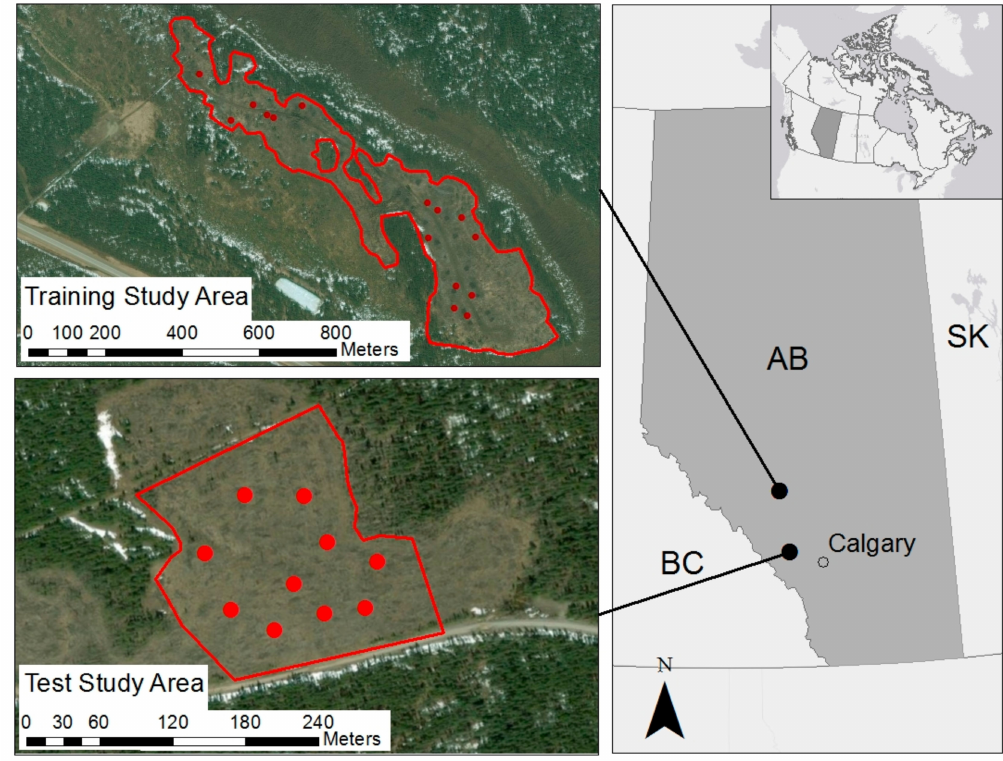
Figure 1. Location of two replanted forest-harvest areas surveyed for this research in southwestern Alberta, Canada. Sample plots within the harvest areas are depicted with the red